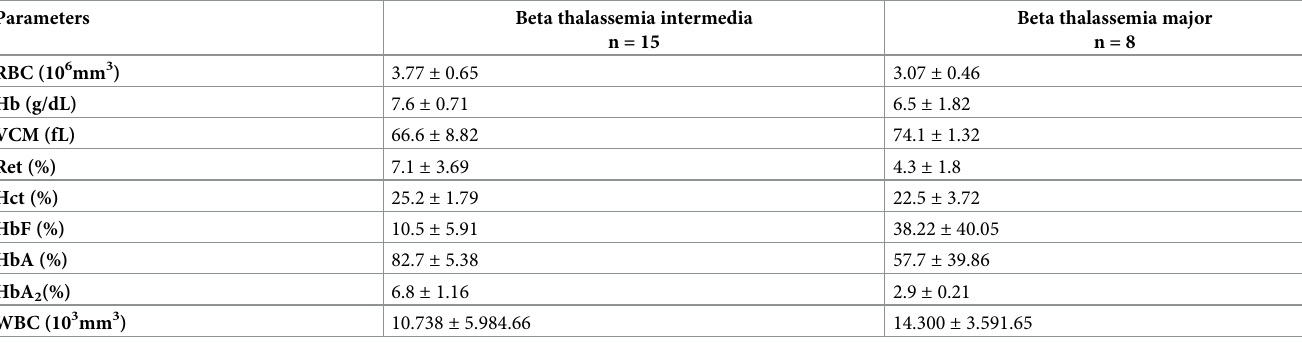
RBC, red blood cell; Hb, hemoglobin; MCV, mean corpuscular volume; Ret, reticulocyte; Hct, hematocrit; HbF, hemoglobin fetal; HbA, hemoglobin A, HbA 2 , hemoglobin A 2 ; WBC, white blood cell. Data are presented as a mean and standard deviation. All BTM patients are under regular transfusion and iron chelation therapy. BTI patients are under non-regular transfusion and without iron chelation